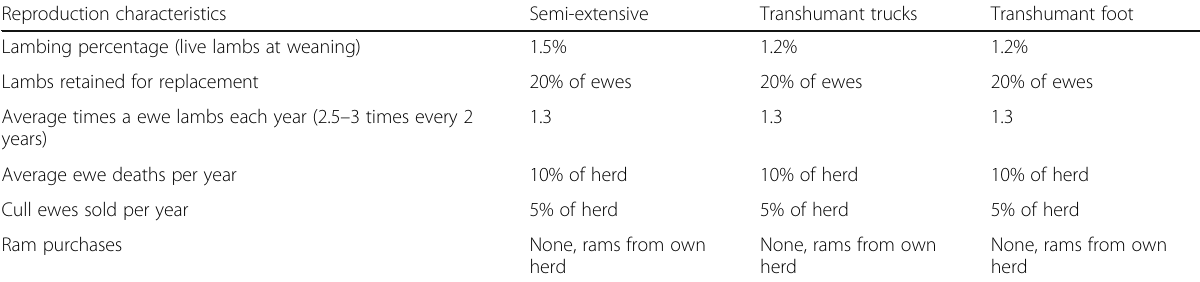
Table 3 Reproduction characteristics of the different operation types Reproduction characteristics